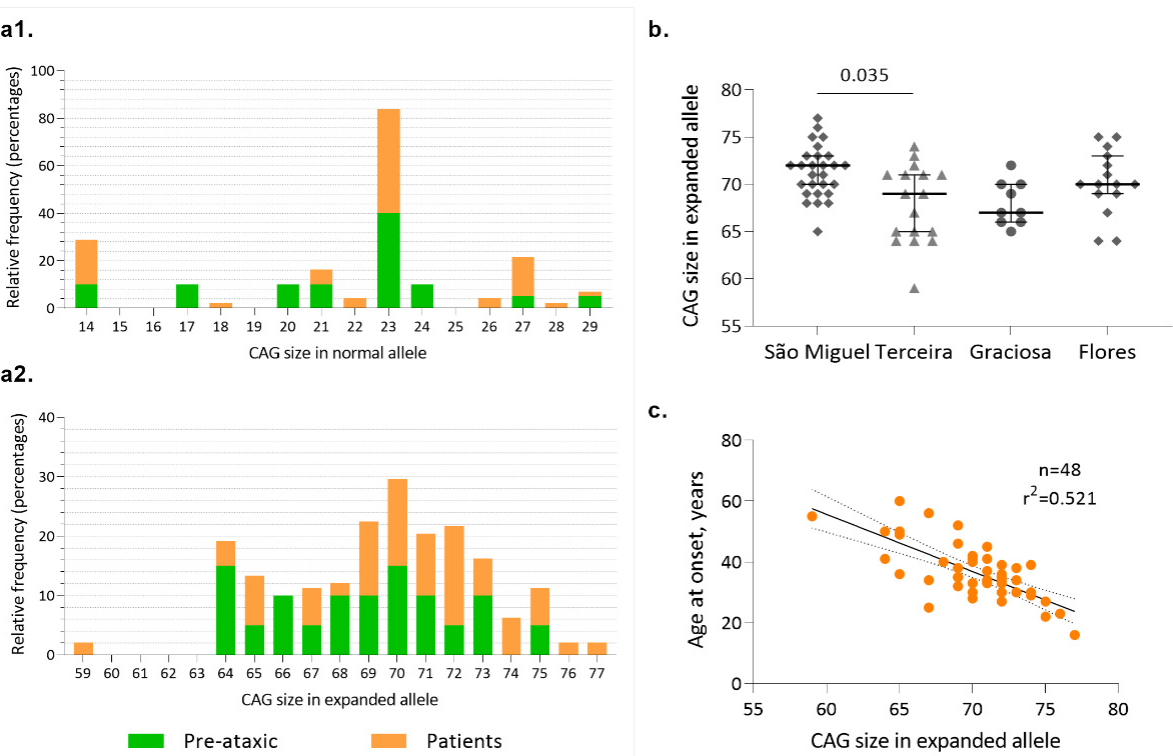
Figure 2. Allelic profile of the CAG repeats at ATXN3 . ( a1 ) Allelic distribution of the normal ATXN3 alleles (n = 69); ( a2 ) Allelic distribution of expanded ATXN3 alleles (n = 69); ( b ) Distribution of the number of CAG repeats at the MJD locus by island of birth of carriers; ( c ) Linear relationship between the CAG number in the expanded allele and age at onset in MJD patients.